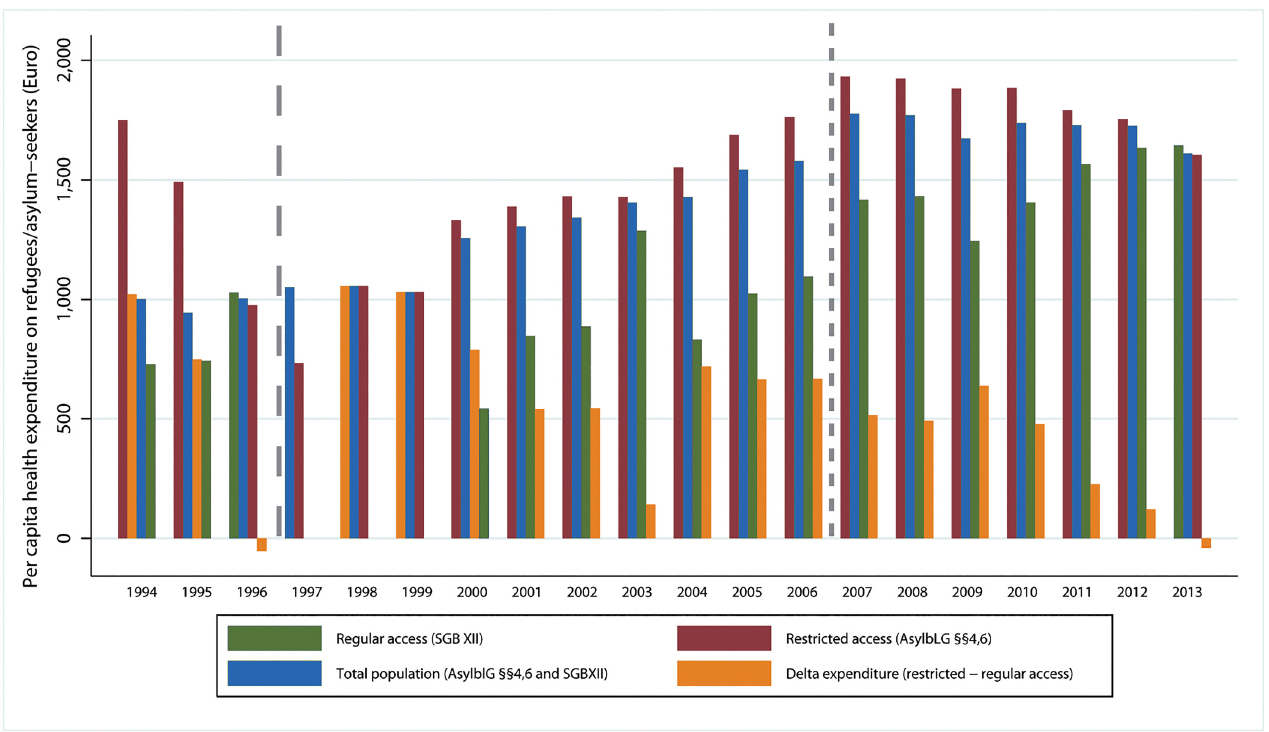
Fig 4. Per capita health expenditure on AS&R by type of access and absolute difference in per capita expenditure on health between the groups with restricted and regular access (1994 – 2013). Long-dashed vertical line: indicates onset of REFORM1 in June 1997, which prolonged the, “ waiting time ” to regular access from 12 months (1994 – 1996) to 36 months thereafter (until 2006). Short-dashed vertical line: indicates onset of REFORM2 in August 2007, which prolonged the, waiting time ” to regular access from 36 months (1997 – 2006) to 48 months (2007 – 2013). The observations in 1997 – 1999 were excluded from the analysis because the group with regular access (on 31 Dec) was zero, thus leading to artificially high differences in expenditures, and in 1997 to artificially high per capita expenditures for the total population. Expenditures for regular access before 2005 refer to expenditures categorised under the Federal Social Security Act ( Bundessozialhilfegesetz